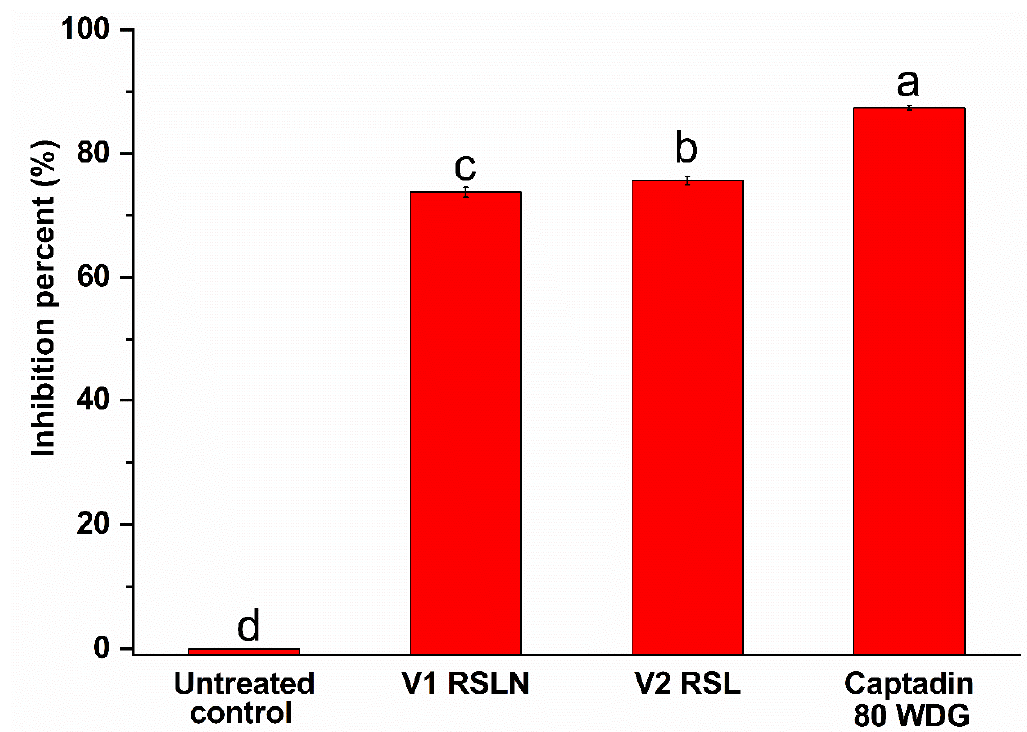
Figure 9. Effect of vegetal extracts in control of apple scab— Venturia inaequalis. Values without a common letter differ ( p < 0.05) as analyzed by one-way ANOVA and the Tukey test.